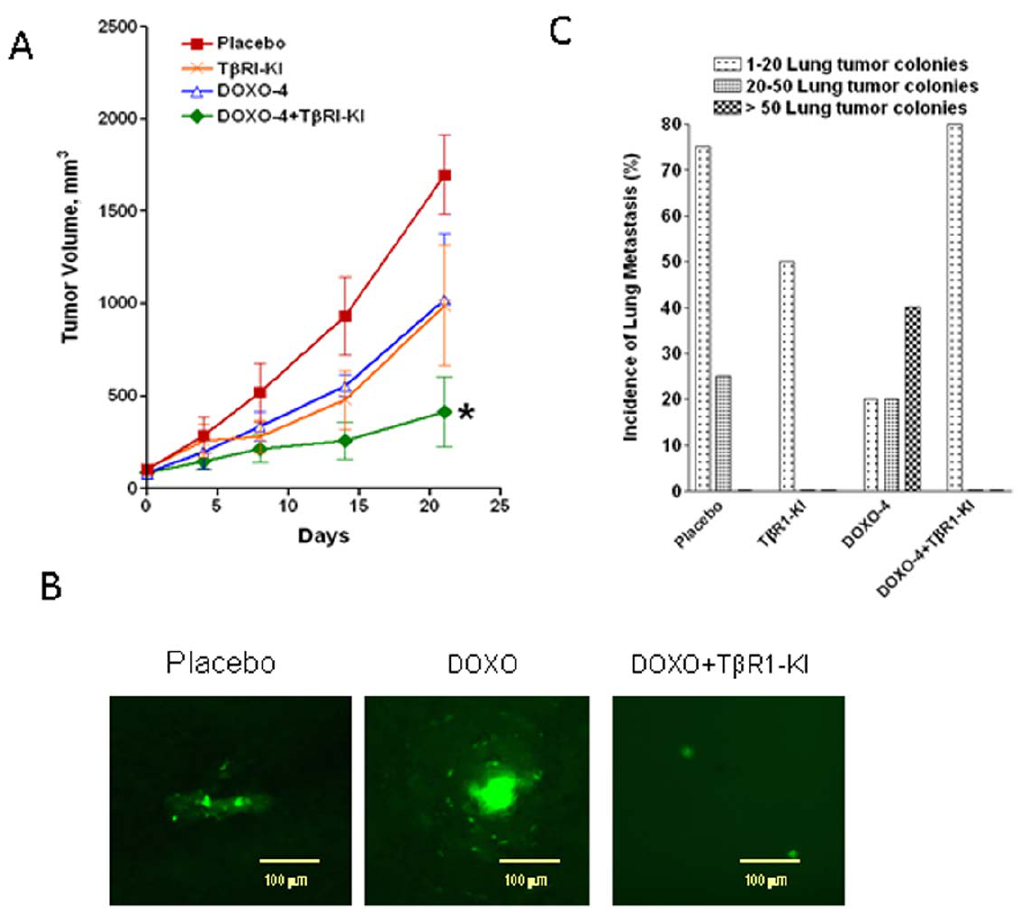
Figure 7. Treatment with T b RI-KI blocked doxorubicin-induced spontaneous lung metastasis of human breast cancer cells . A. EGFP- expressing sub confluent MDA-MB-231 cells (1 6 10 6 ) were inoculated into both inguinal mammary fat pads of female athymic nude mice. Tumor volume was measured externally and calculated as described in the legend of Figure 5. Tumors were allowed to reach 80–100 mm 3 in size and the animals were then ranked according to their tumor burden and divided into four groups such that the mean and the median of the tumor volume of the groups are closely matched. Animals were treated with PBS (control), T b RI-KI every alternative day, doxorubicin once every week, and with the combination of T b RI-KI and doxorubicin respectively. The experiment was terminated after 3 weeks and the final tumor volume (sum of two tumors per mouse) was used for calculating mean tumor volume 6 SEM from 4 mice in control and T b RI-KI groups and 5 mice in the other two groups. Asterisk ‘‘*’’ denotes significant difference (P , 0.05) of the terminal tumor volumes between control and the combination treatment group by ANOVA. B. Representative Pictures of lung metastasis colonies formed by EGFP-expressing MDA-MB-231 cells detected by fluorescence microscopy ( 6 200 magnification). C. Green fluorescent micrometastatic colonies in the whole lung were detected and counted. The percent of mice with lung metastasis in each group is expressed as total lung metastasis incidence. Incidence as percent of mice with numbers of lung metastasis colonies ranging between 1 and 20, between 20 and 50, and . 50 is also